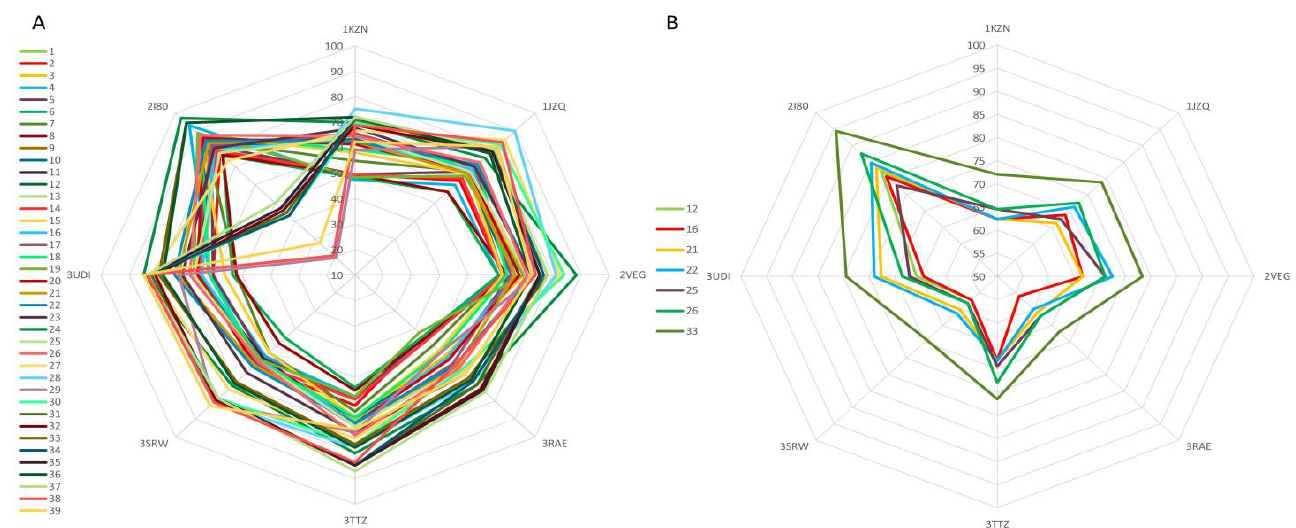
Figure 2. Graphical representation of the docking scores related to antimicrobial protein targets, corresponding to 39 TPEO components ( A ) and 7 major TPEO constituents ( B ) (representing over 75% of the oil); docking scores calculated as a percentage of the native ligand’s score of each target protein; the results are plotted in the form of a radar chart where docking scores (recalculated as a percentage of the native ligand’s docking score) of each compound, represent a series and the target proteins are in the corner of the graph.